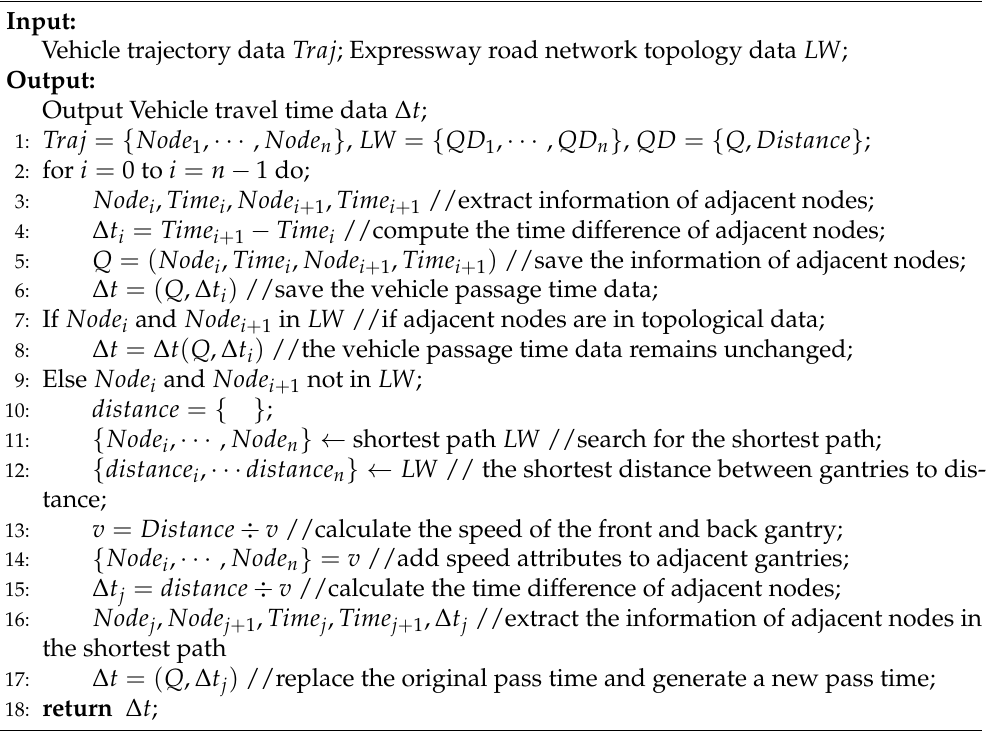
Figure 3. Types of abnormal data (**** indicates that the data was desensitized) ( a ) Data redundancy ( b ) Missing data ( c ) Data errors. Algorithm 1 Vehicle travel time construction